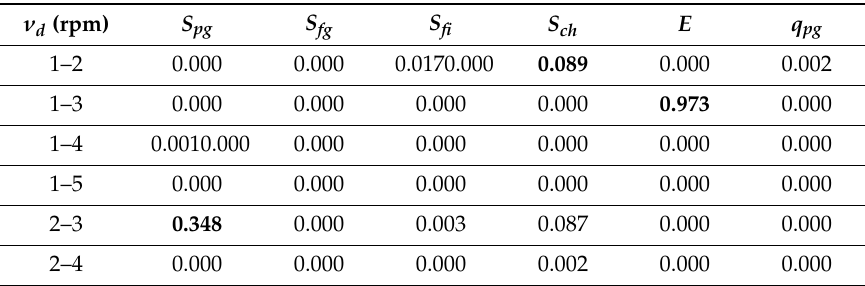
Table 7. Tukey’s HSD test for the